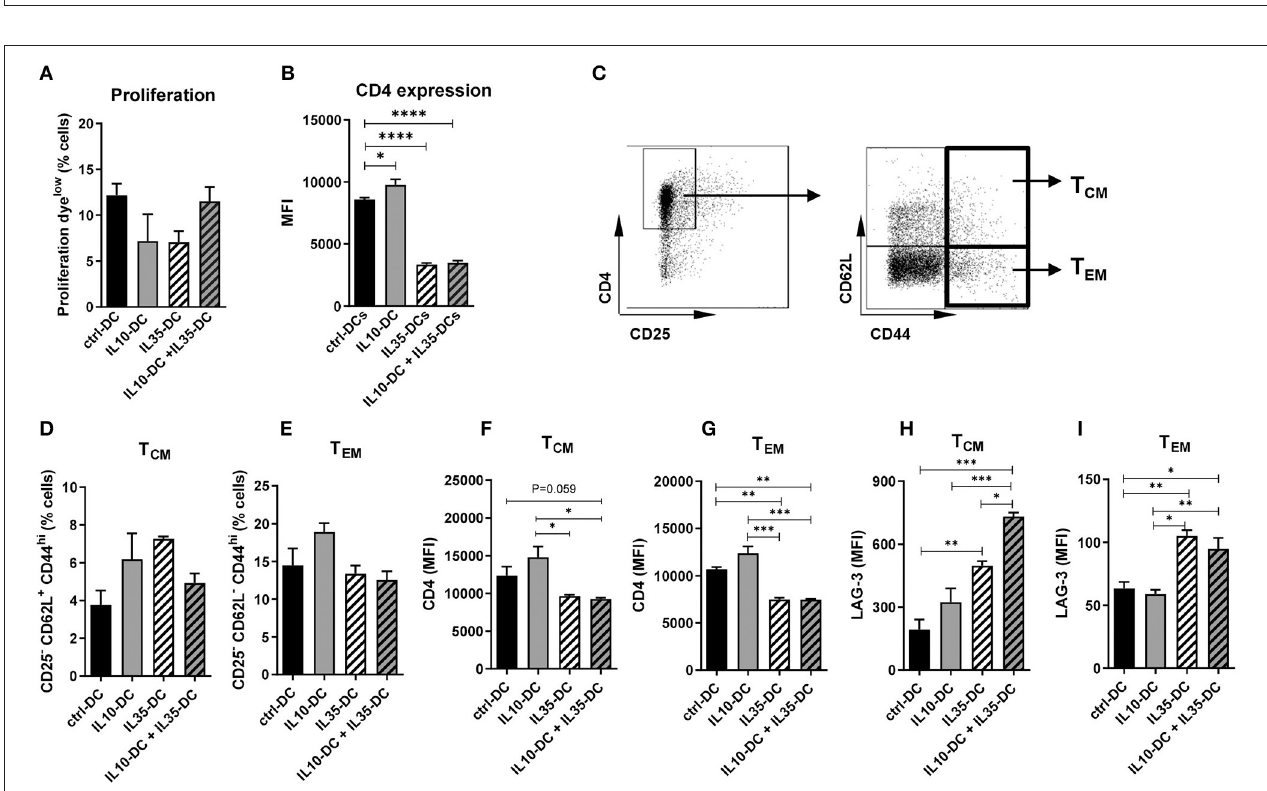
FIGURE 4 | erythema, swelling, and ankylosis. (A) Schematic timeline of the experimental procedures. (B) Cumulative arthritis scores; CII-DC transfers are indicated by the arrows. (C) Probability of recovery evaluation of mice after the second DC transfer based on cumulative score reduction: each mouse was analyzed for having its scores reduced or not. (D) Individual score evolution of sick mice after the second DC transfer: each line represents the increase (full lines) or decrease (dashed lines) of the cumulative score ( y axis) of one individual during days 21 to 28 ( x axis). In a second approach, 1 week after immunization, five groups of mice were implanted with bioactive cellular implants secreting IL-10, IL-35, IL-10, and IL-35, or empty implants. (E) Schematic timeline of the experimental procedures. (F) Cumulative arthritis scores. (G) Individual score evolution of sick mice 1 week after the implantation of device: each line represents the increase (full lines) or decrease (dashed lines) of the cumulative score ( y axis) of one individual during days 14 to 26 ( x axis). Data are representative of at least two independent experiments ( n = 3–10 mice/group/experiment). * P < 0.05.